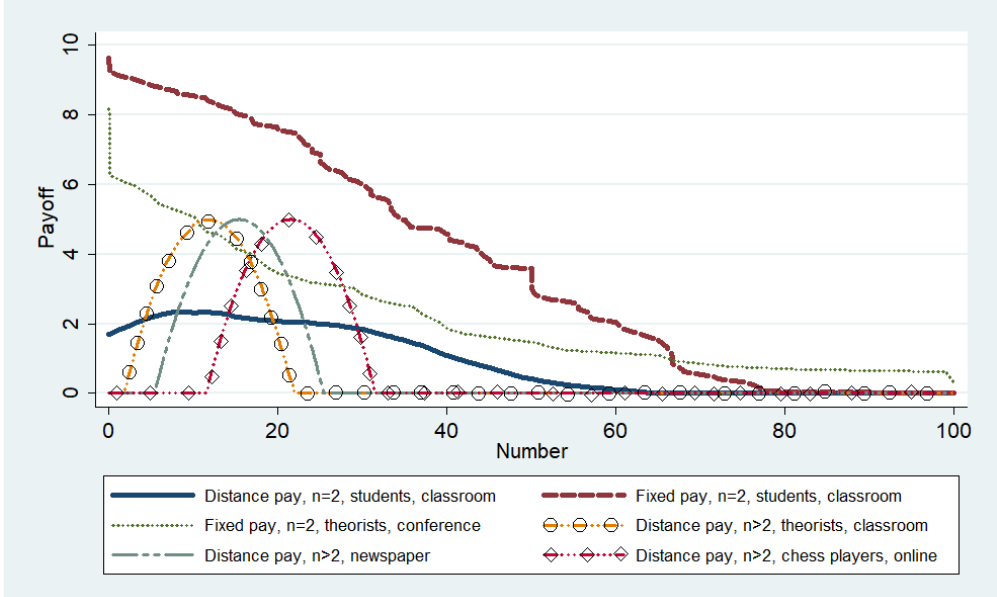
Figure 4: Expected payoffs of choices by treatment (see Nagel et al., 2016)